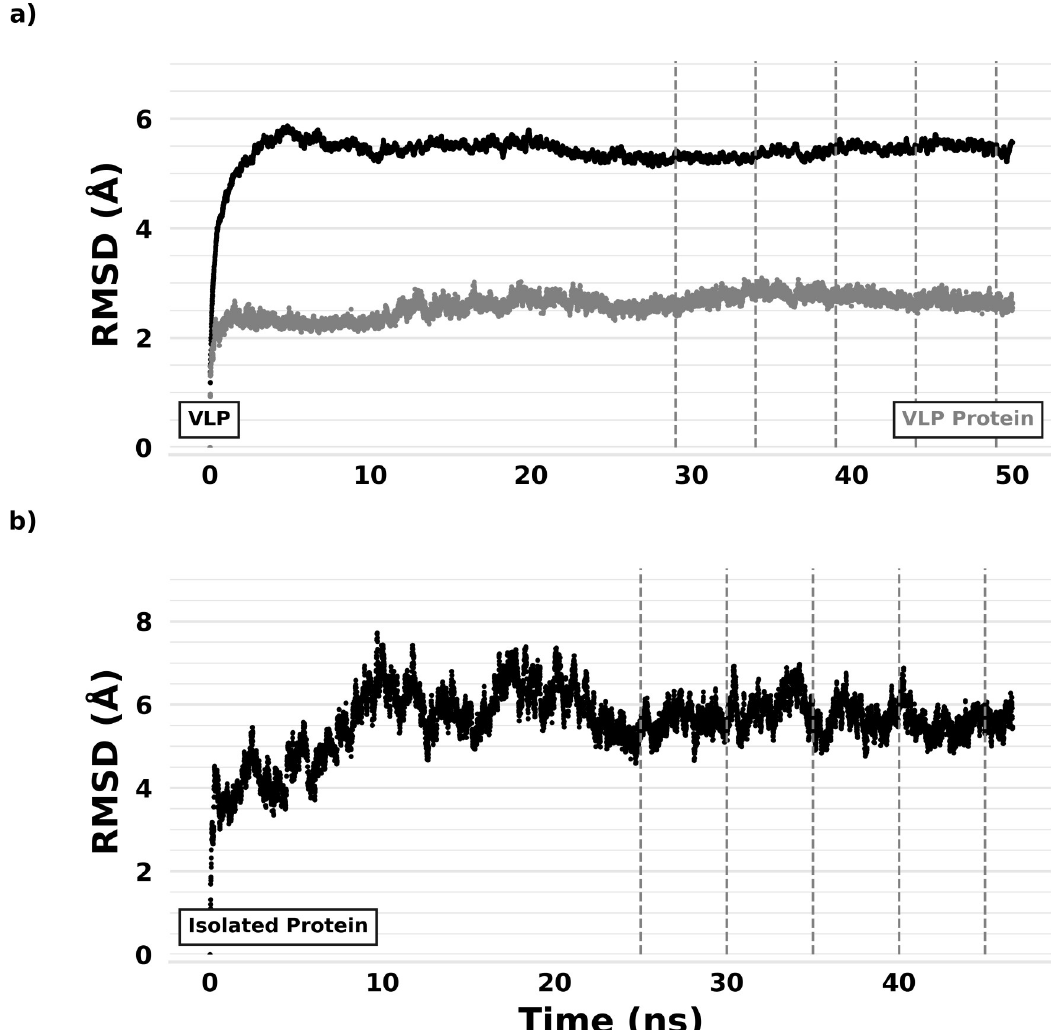
Fig 1. ZIKV structural equilibration at 300 K. a) RMSD from starting configuration for a) the ZIKV VLP (black trace), a single VLP protein (gray trace), and b) the isolated ZIKV protein are shown. Vertical lines represent trajectory bounds used for RMSF